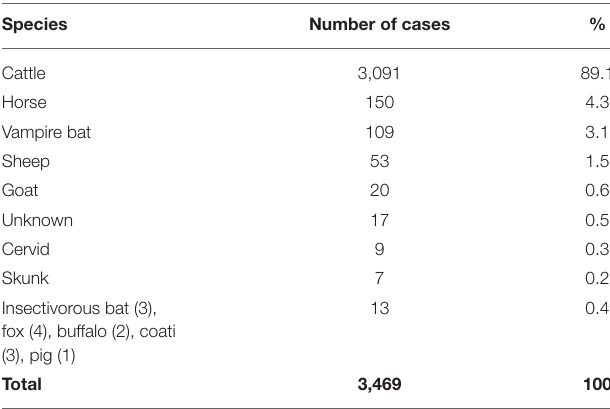
TABLE 1 | Frequency of the number of cases of rabies in different livestock and wildlife species in Mexico,